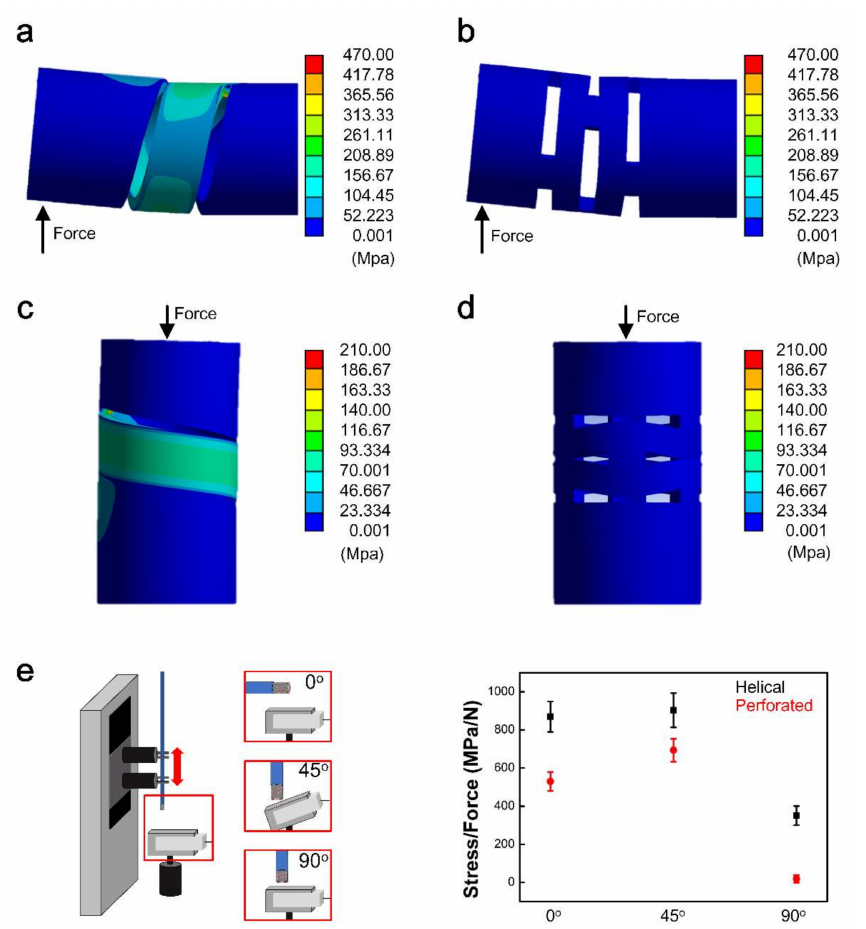
Figure 2. Stress distributions for 0.5 N loading by ANSYS. ( a ) Lateral force analysis for the helical structure and ( b ) perforated pattern structure. ( c ) Axial force analysis for the helical structure; and ( d ) perforated pattern structure. ( e ) Three-degree conditions for force (0, 45, 90 ◦ ) with the sensitivity of helical and perforated pattern structures ( n =